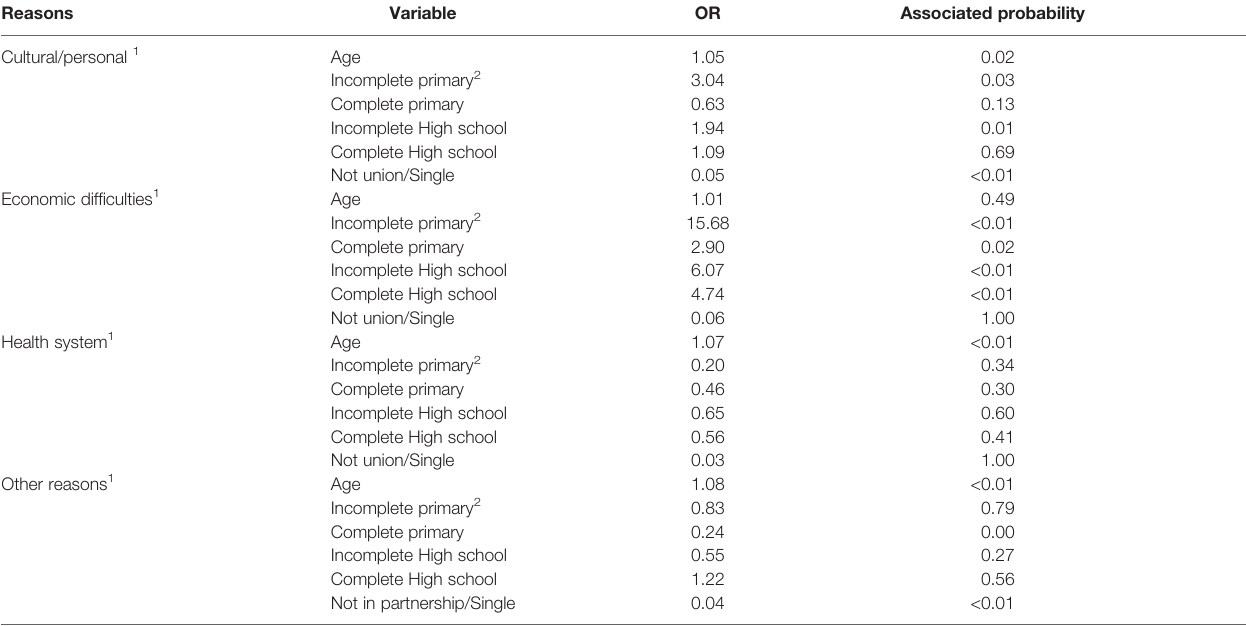
TABLE 4 | Reasons why women have never had a Pap smear screening.